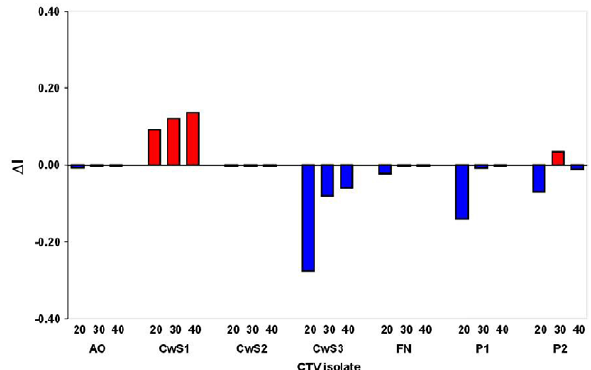
Figure 4. ΔI values of phylogenetic group richness in relation to increasing number of sampled clones averaged over 24 possible sampling orders of four sets based on the results of the classification proposed by Nolasco et al .